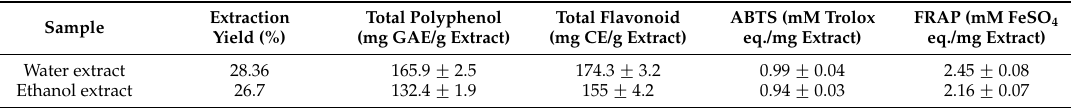
Table 1. Total polyphenol and flavonoid content of CSL